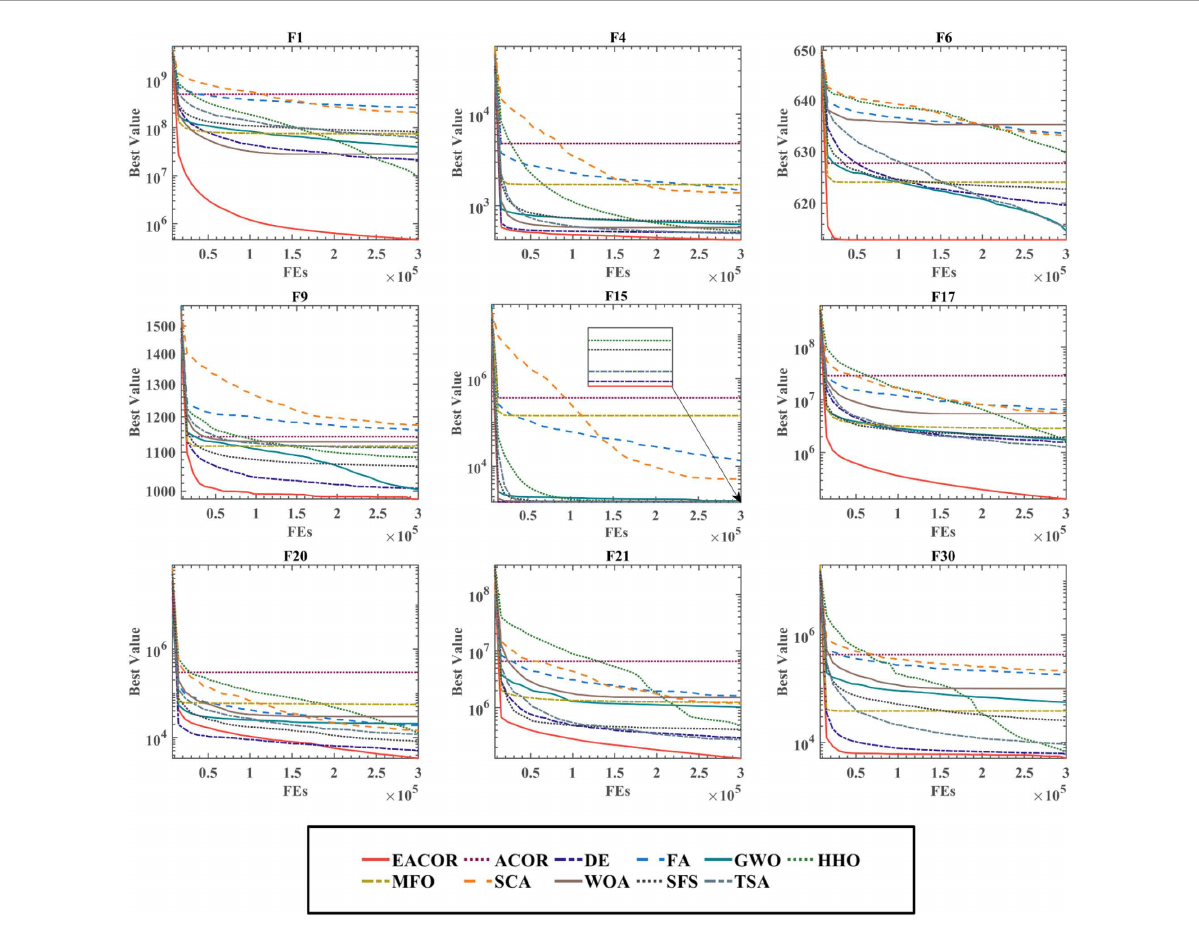
FIGURE10 Convergence curves of EACOR with ten original